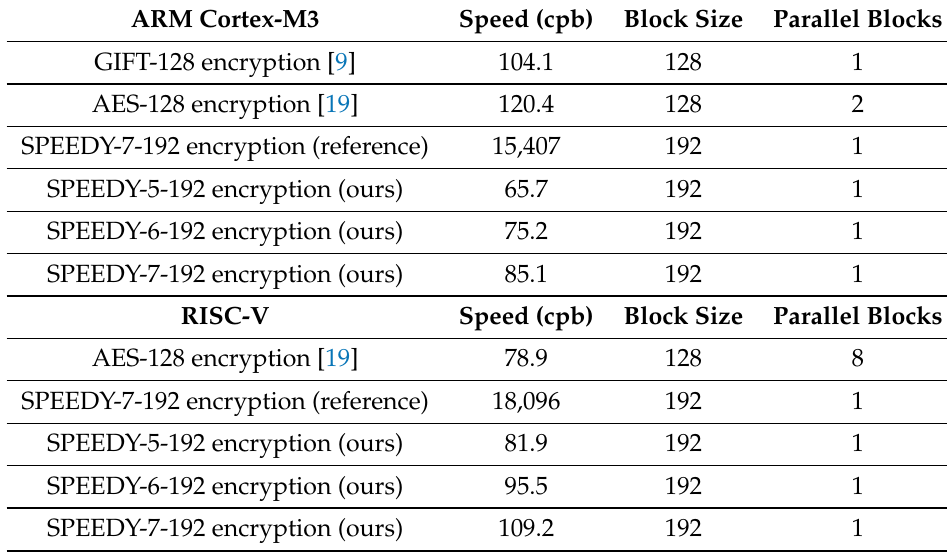
Table 3. Comparison of SPEEDY implementation results and various constant-time implementation results on ARM Cortex-M3 and RISC-V. The performance is evaluated in clock cycles per byte